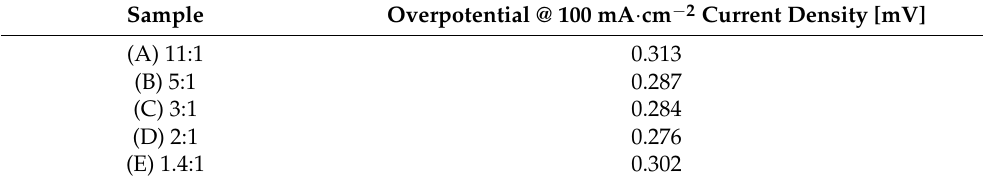
Table 2. Overpotential at 100 mA/cm 2 of the electrodeposited Ni–Zn–Fe electrodes on Ni foam in the different Ni:Fe ratio of the bath (A), (B), (C), (D), (E) (Condition: scan rate = 0.1 mV/s, temperature = 25 ◦ C, KOH = 1